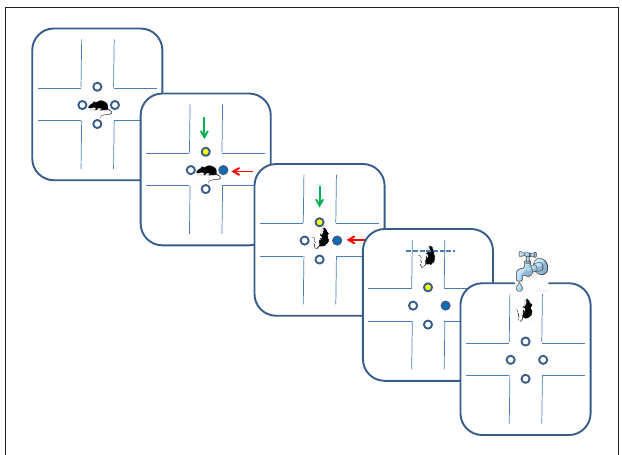
FIGURE 1 | Multidimensional learning paradigm and trial progression. Blue and yellow dots depict illuminated LEDs, and green and red arrows indicate different odors. In the depicted trial, rats received reward for following the green odor in an odor-set phase of the task, or for following the yellow color in a LED-set phase of the